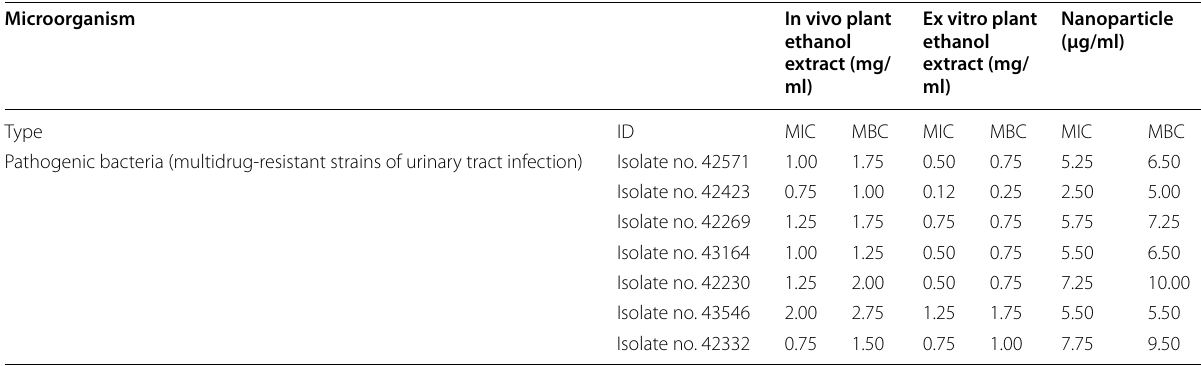
Isolate no. 42571, Escherichia coli ; isolate no. 42423, Escherichia coli ; isolate no. 42269, Klebsiella pneumoniae ; isolate no. 43164, Klebsiella pneumoniae ; isolate no. 42230, Pseudomonas aeruginosa ; isolate no. 42332, Pseudomonas aeruginosa ; isolate no. 43546, Staphylococcus saprophyticus